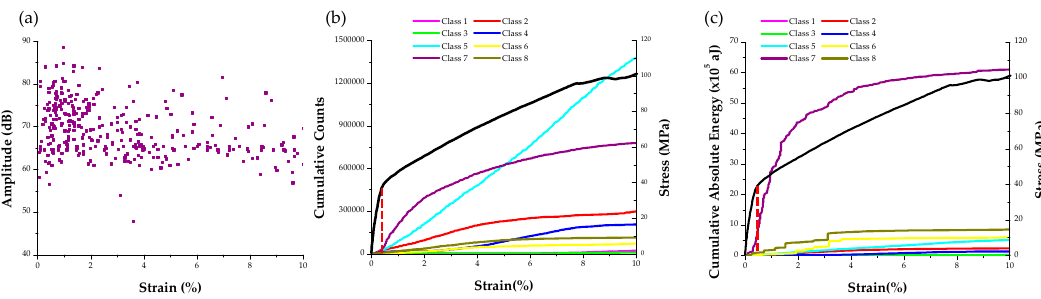
Figure 11. ( a ) Amplitude vs. strain of the reclustered class 7; ( b , c ) cumulative AE counts and absolute energy of all classes as a function of strain and compared with the stress–strain curve of the ND specimen.